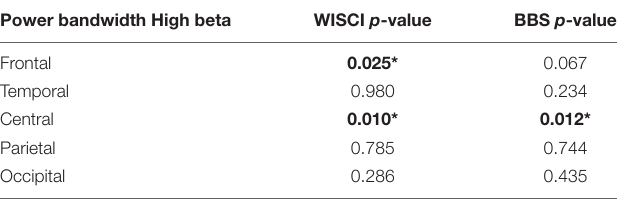
TABLE 2 | Baseline EEG predicted by functional